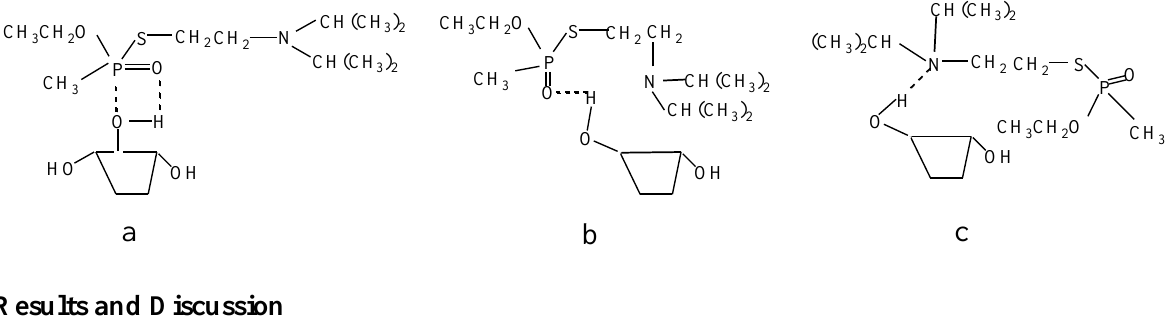
Figure 3. Reaction between self-assembled imprinted film and